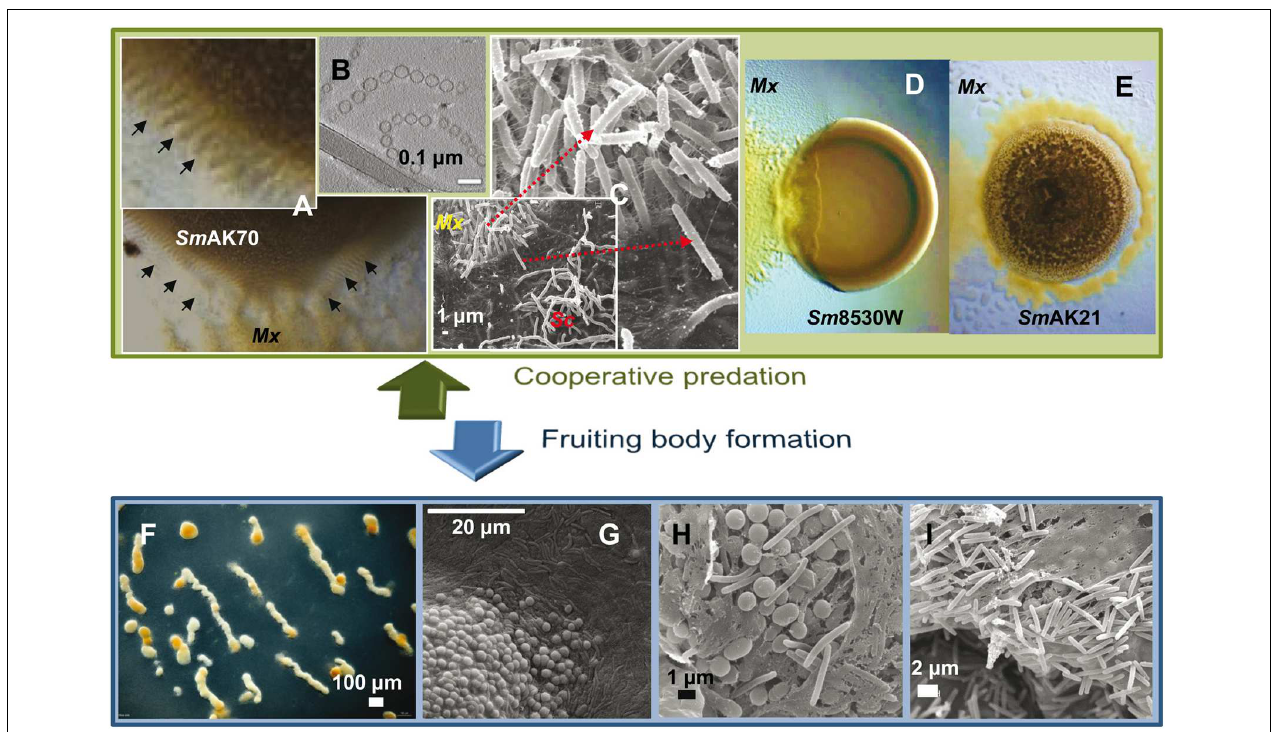
FIGURE 3 | Myxococcus xanthus multicellular behaviors. (A) M. xanthus DK1622 coordinated movements (rippling) induced by Sinorhizobium meliloti AK70 ( Sm AK70) during predation. (B) OMV chains cryofixed and visualized by transmission electronic microscopy. OMVs contain multiple hydrolytic enzymes and secondary metabolites indicating an important role in killing and lysis of prey. (C) Scanning electron micrographs of the interface DK1622 ( Mx ) versus Streptomyces coelicolor M45 ( Sc ) cells after 96 h of incubation. The magnified picture shows the intense ECM connection between the attacking cells. (D) Frontal attack strategy: M. xanthus DK1622 ( Mx ) versus a non-mucoid colony of S. meliloti 8530W ( Sm 8530W). (E) Wolf pack attack strategy: M. xanthus DZ2 (Mx) versus a mucoid colony of S. meliloti AK21 ( Sm AK21). (F) M. xanthus DZF1 fruiting body formation after 72 h on starvation medium. (G–I) Scanning microscopy of M. xanthus DZF1 fruiting body showing the round spores and the surrounding peripheral rods. (H,I) Within the fruiting bodies, the myxospores are firmly bound together by a cohesive ECM. Picture (B) has been adapted from Remis et al. (2014) with permission, copyright 2013 Society for Applied Microbiology and John Wiley & Sons